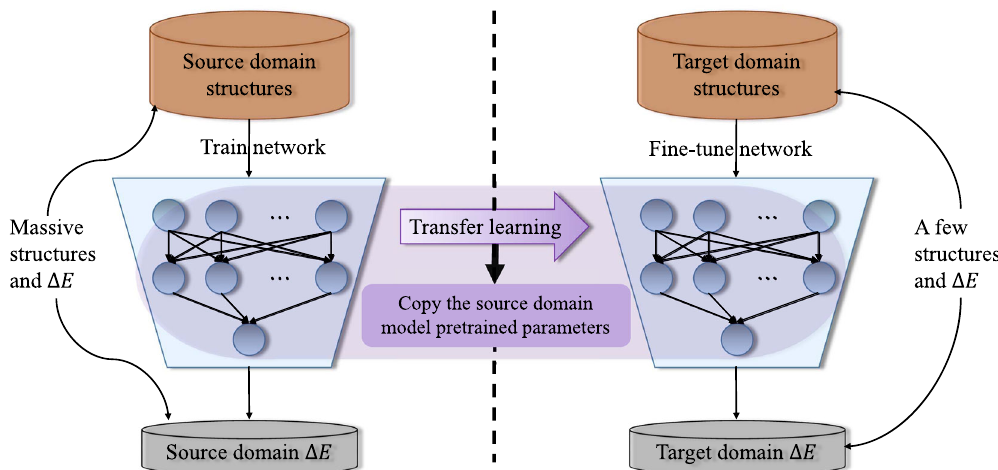
Fig. 3 Schematic diagram of transfer learning. The model of Pb(II)/g-C 3 N 4 was chosen as the source domain, with massive structures and Δ E , while the models of Hg(II)/g-C 3 N 4 and Cd(II)/g-C 3 N 4 were target domains, with a few structures and Δ E . In the training of Hg(II)/g-C 3 N 4 and Cd (II)/g-C 3 N 4 , the parameters in Pb(II)/g-C 3 N 4 model were taken as the starting points for Hg(II)/g-C 3 N 4 and Cd(II)/g-C 3 N 4 , instead of randomly initializing parameters, and then the parameters were further fi ne-tuned for